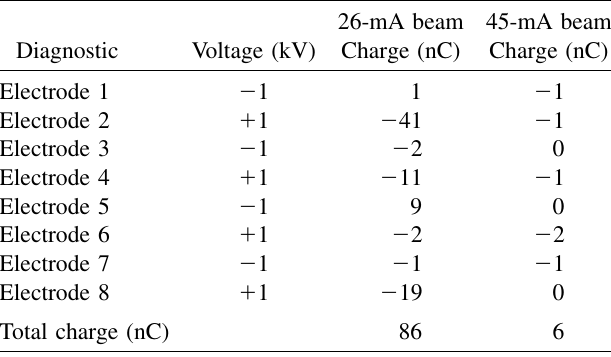
TABLE I. Comparison of the charge collected on the electron cloud diagnostics for the 45-mA beam and the apertured 26-mA beam for the clearing case.